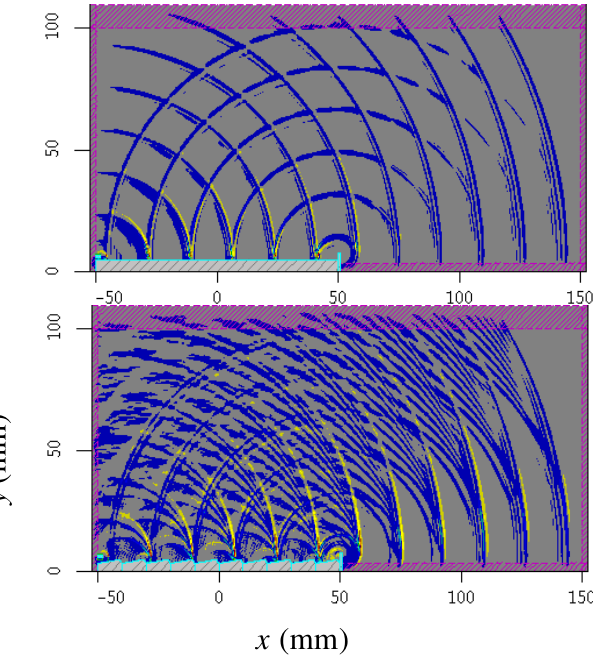
FIG. 8. (Color) B contour maps with a flat ground plane (upper) z and with a grating (lower) (MIT).